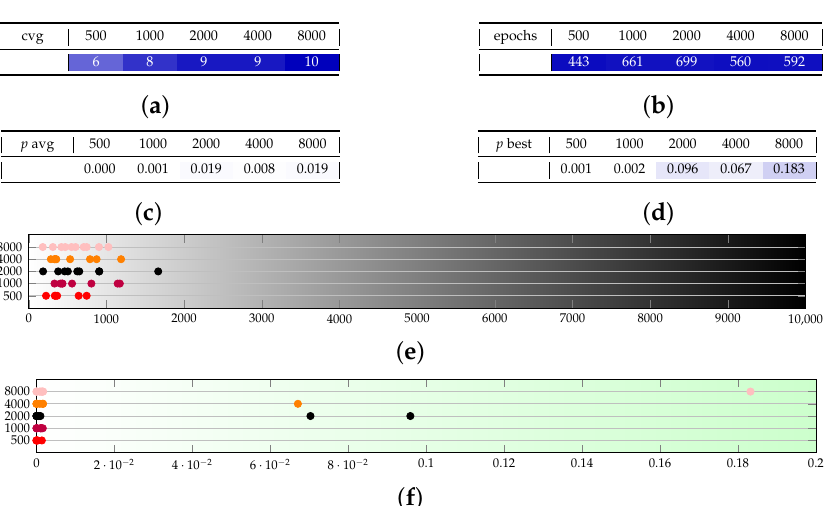
Figure A13. The test set L provides a sensitivity analysis on the number of shots s for n = 4 qubits. ( a ) Converging runs, out of 10. ( b ) Number of epochs before convergence, on average. ( c ) p -value for the χ 2 test once convergence is reached (average over converging runs). ( d ) p -value for the χ 2 test once convergence is reached (best run). ( e ) Visual representation of the epochs before convergence. ( f ) Visual representation of the p -value, zoomed on p 0.2 as no points have p >